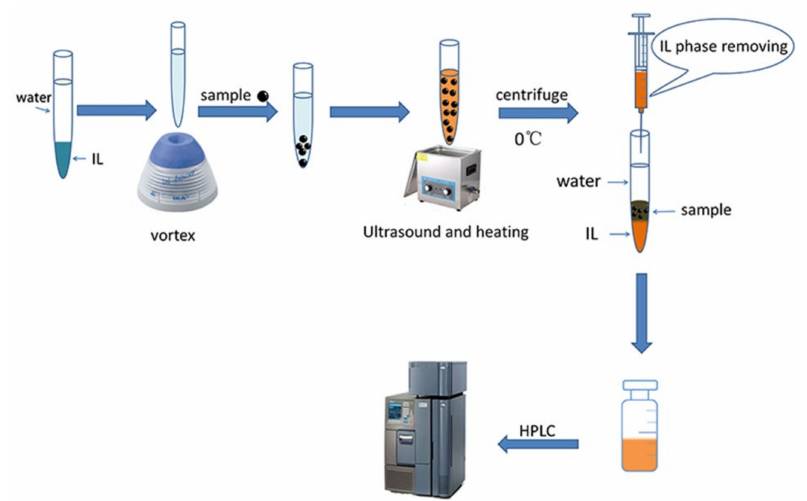
Figure 2. Scheme of centrifugal process, ( a ) before centrifugation and ( b ) after centrifugation.